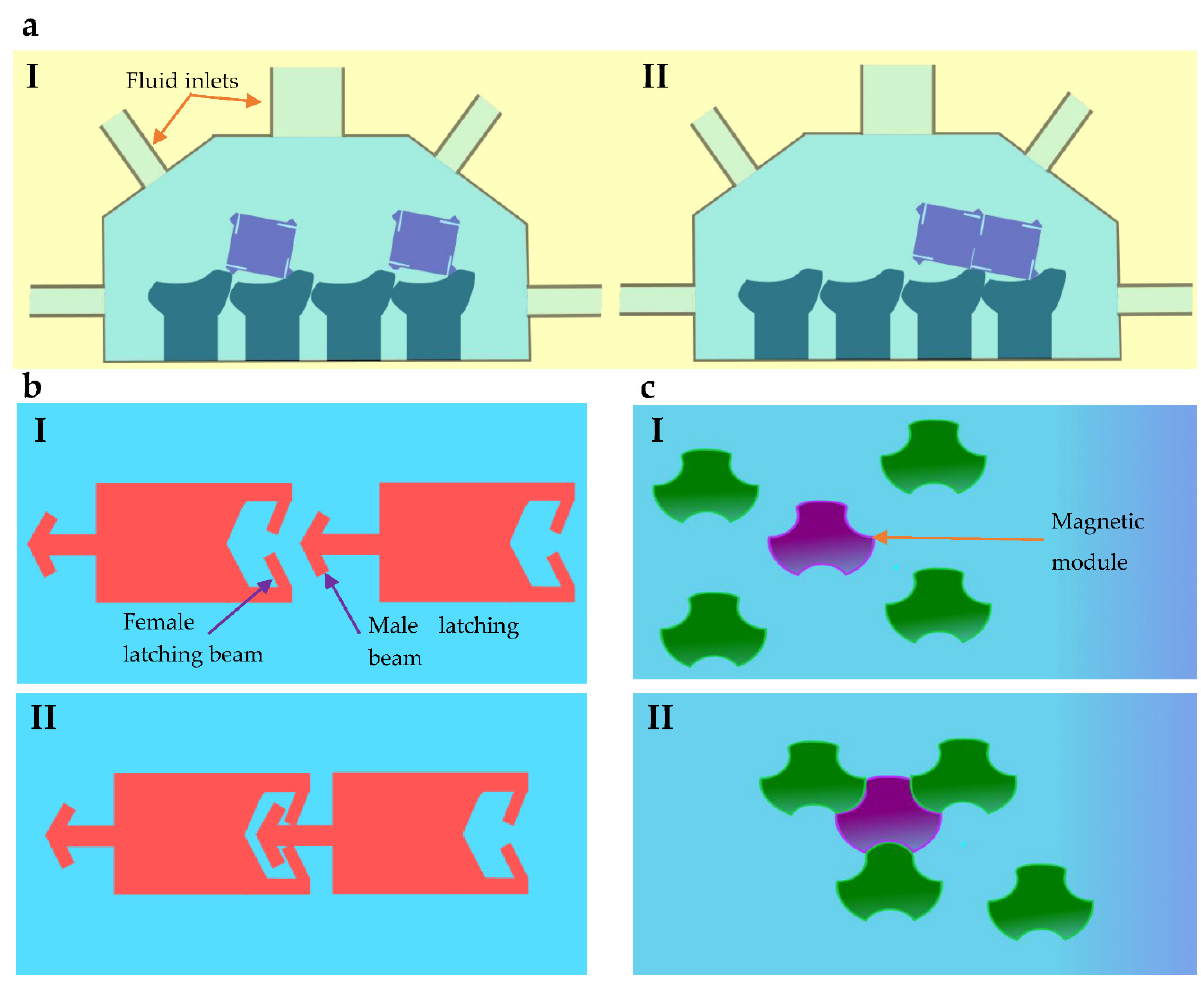
Figure 7. Other selective control methods: ( a ) Silicon tile assembly formation using selectively controlled fluidic flows [96]. ( b ) Micromodules that have male and female connecting structures are interconnected using a rail-guided method [97]. ( c ) Magnetic modules are guided selectively to bond connections with other non-magnetic modules using thermal bonding [98].